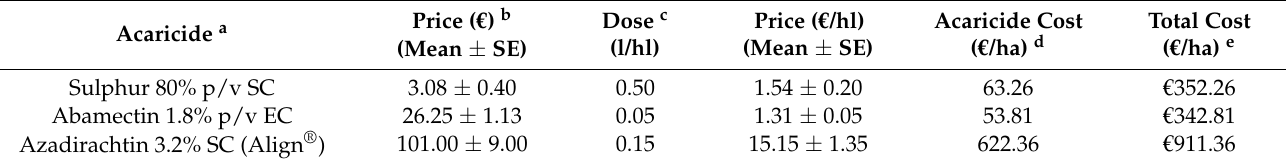
Table 2. Plant protection products used in O. perseae control, dose, price per 100 L (hl), acaricide cost and total cost of treatment, based on interviews of field technicians on the Canary Islands (at the time of this